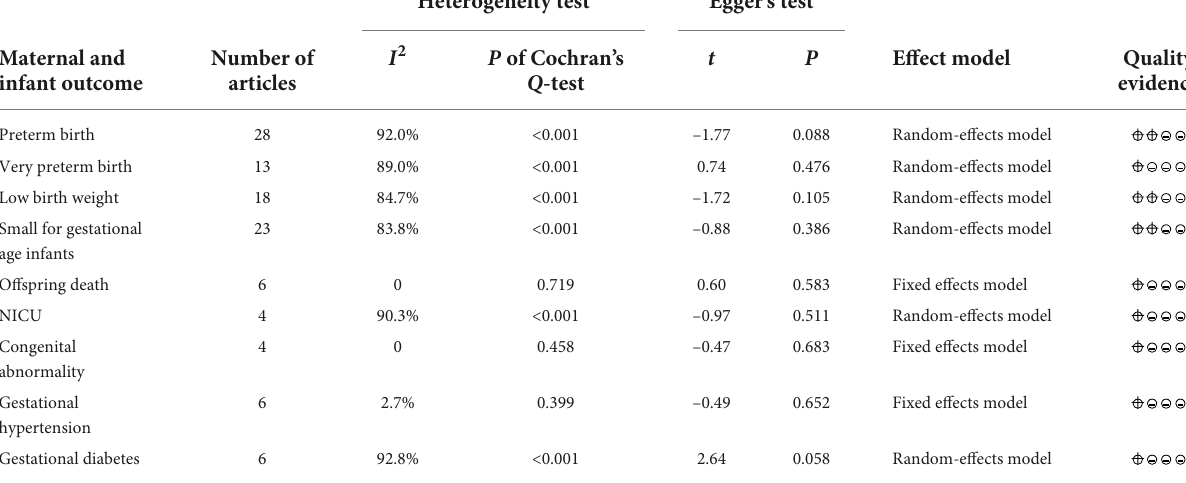
TABLE 1 Heterogeneity test and publication bias test of the meta-analysis of various pregnancy